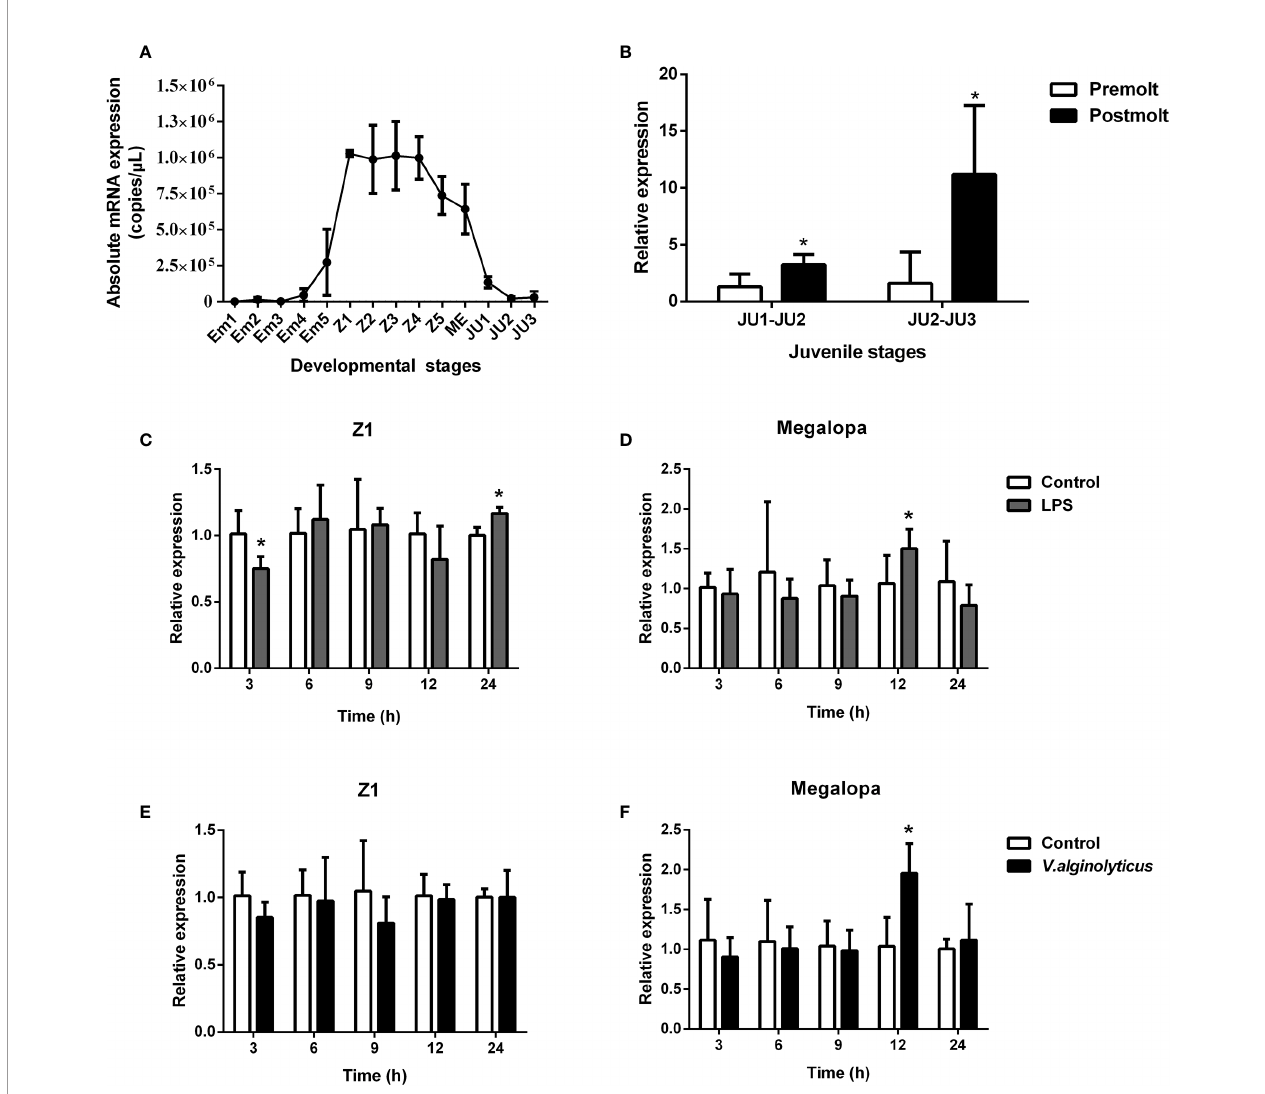
FIGURE 2 | Expression pro fi les of SpCTL6 gene in the developmental stages of S. paramamosain . (A) The expression of SpCTL6 in the different developmental stages of S. paramamosain was determined by absolute qPCR (n=5). Em1-Em5: embryonic stage 1-5; Z1-Z5: zoeal larval stage 1-5; ME: megalopa; JU: juvenile crab. (B) The expression of SpCTL6 in molting process of juvenile crabs was analyzed by relative qPCR (n=5); The expression pattern of SpCTL6 in Z1 (n=5) and megalopa (n=5) after LPS (C, D) and V. alginolyticus (E, F) challenges was analyzed by relative qPCR. Signi fi cant difference was indicated by asterisks as * p <